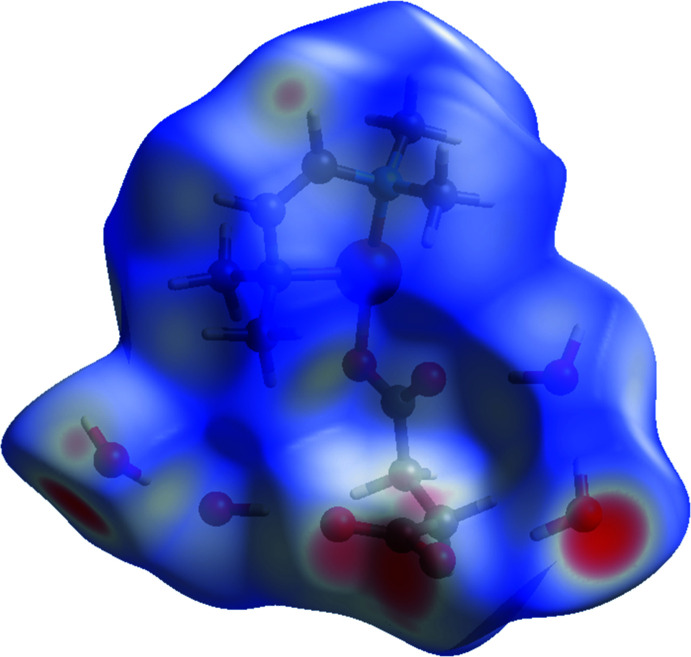
Hirshfeld surface mapped over dnorm for {[Cu(succ)(tmeda)]·4H2O}n.